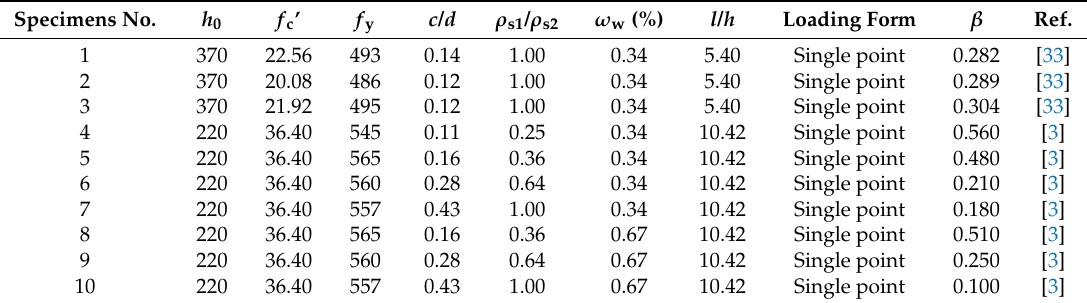
Table 5. Experimental datasets collected from the